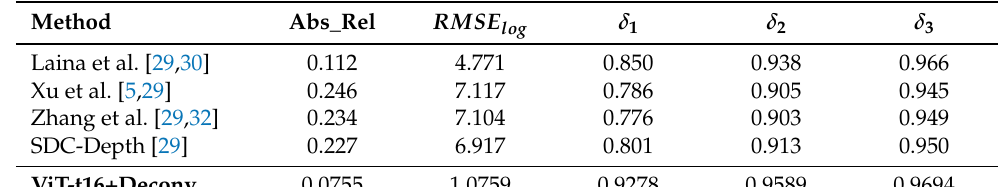
Table 3. Comparison between the proposed method (specifically ViT-s16+Deconv and ViT-t16+DS) and the SOTA methods on the CITYSCAPES depth estimation test set with respect to the Abs_Rel, RMSE log , and the delta accuracies ( δ 1 , δ 2 , and δ 3 ).